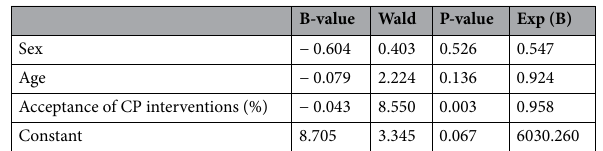
Table 3 for the results of treatment guidelines adherence.